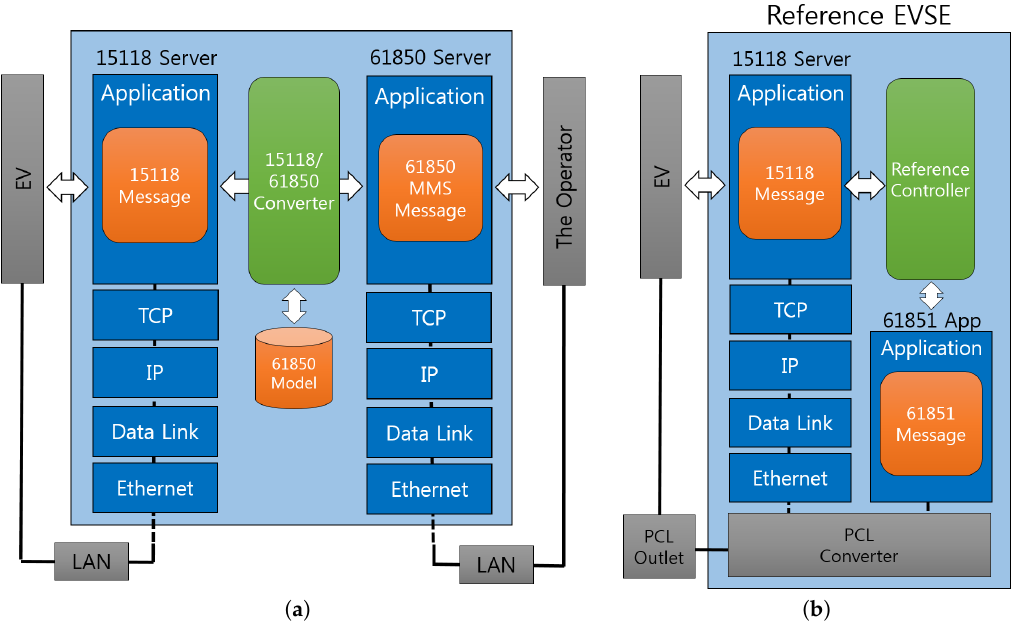
Figure 9. Architecture of the reference chargers. ( a ) Reference charger with high-level stack and IEC 61850; ( b ) Reference charger with full ISO/IEC 15118